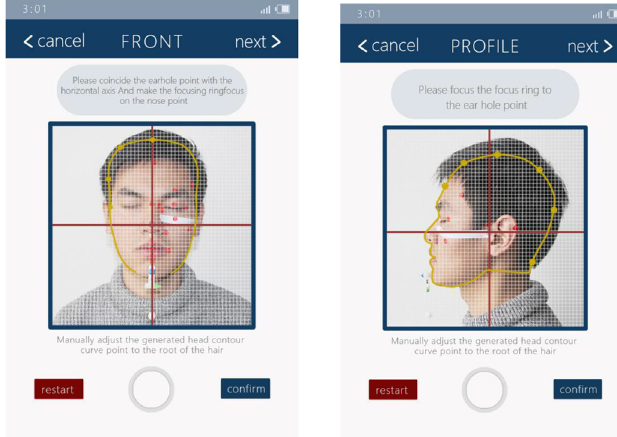
Fig. 21. Photographing